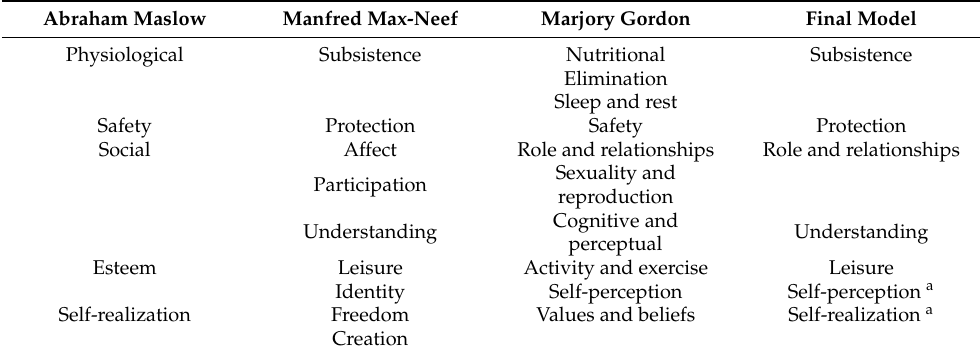
Table 4. Basic human needs according to Abraham Maslow, Manfred Max-Neef and Marjory